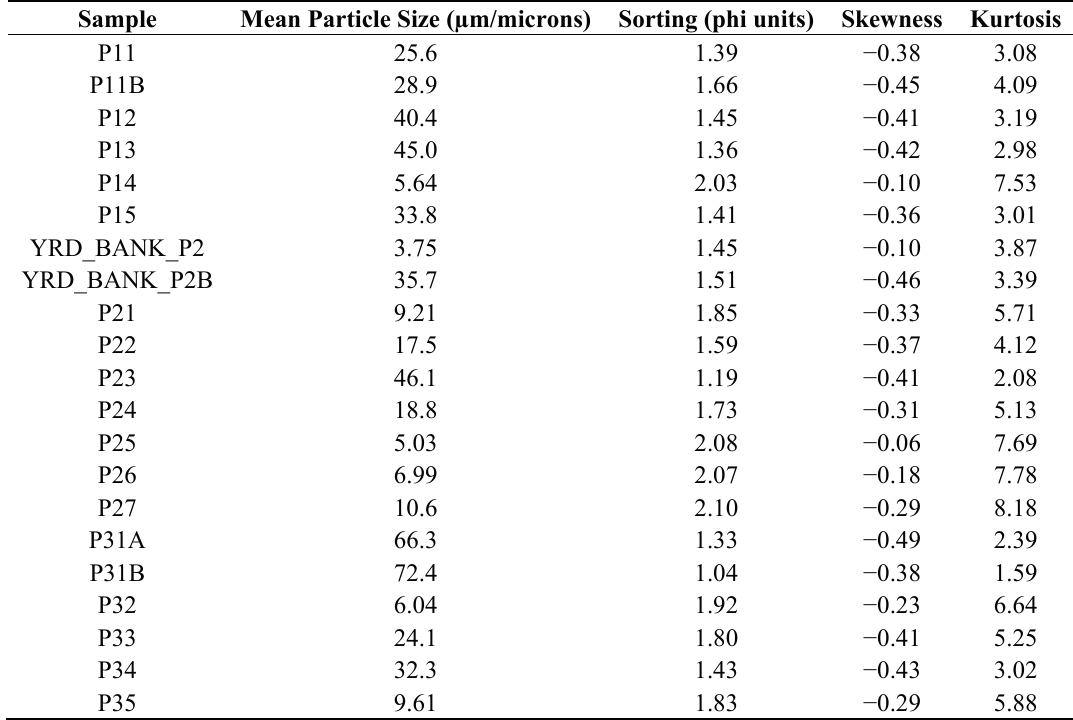
Table C1. Particle size statistics for shallow samples from the Yellow River delta. Sorting, skewness and kurtosis were calculated using the formulae given by Folk and Ward